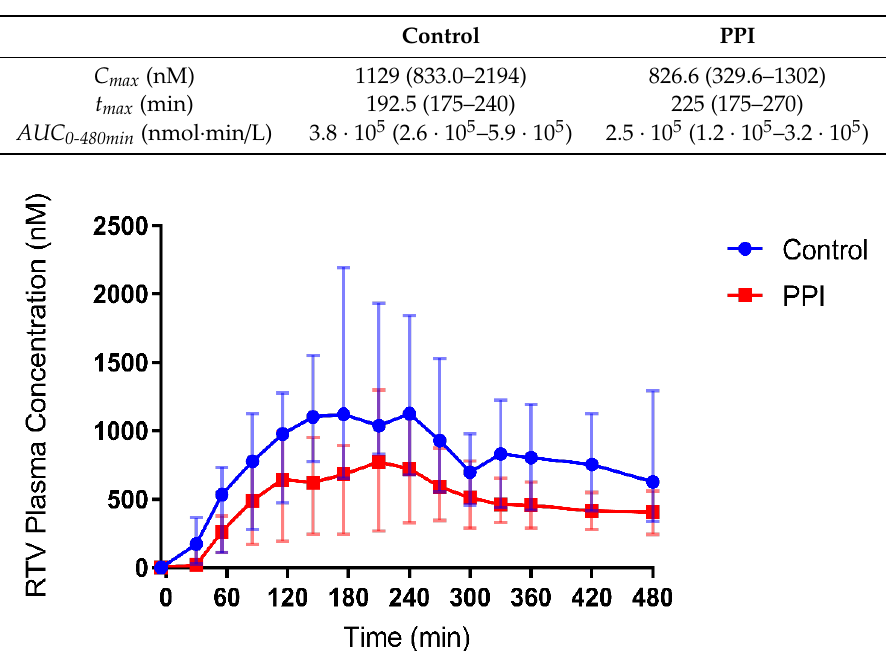
Figure 2. Median plasma concentration-time profiles for ritonavir (RTV) following oral intake of a Norvir tablet in control condition (blue dots) versus PPI condition (red squares). The error bars depict range (n = 4).